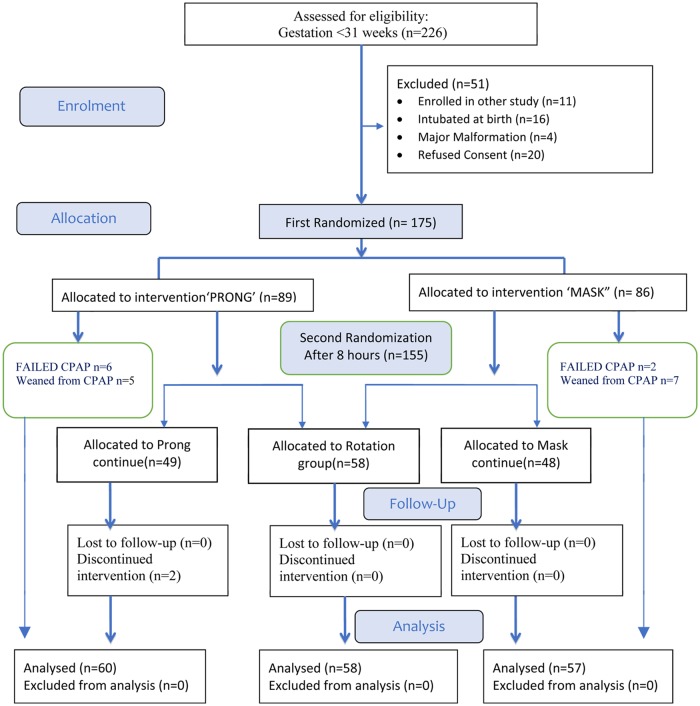
Consort flow diagram of the study participants.